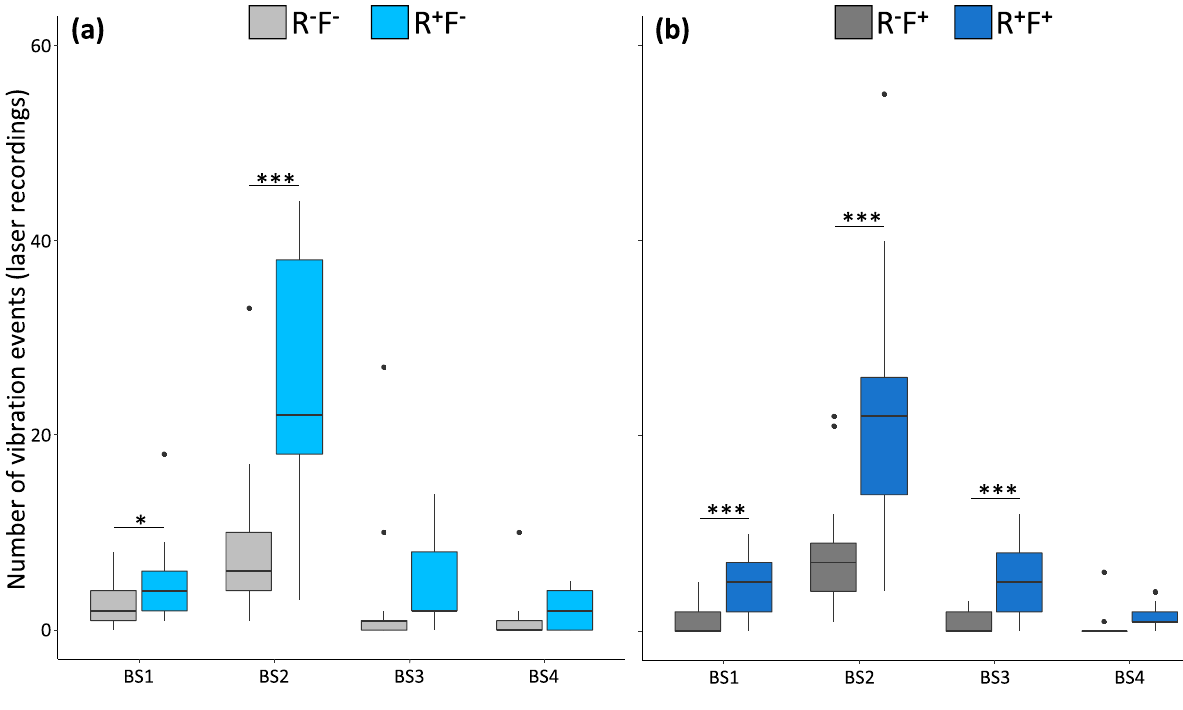
Figure 4. Total number of the vibration events (laser recordings) for the different types of body-shaking (BS1-4). Treatments: absence of reproductives (R − ), presence of reproductives (R + ), absence of flashlight (F − ), presence of flashlight (F + ). Datasets are regrouped in presence ( a ) or absence ( b ) of flashlight. Significant effects of the presence of the reproductives are indicated by stars (* p < 0.05; *** p < 0.001). Dots indicate